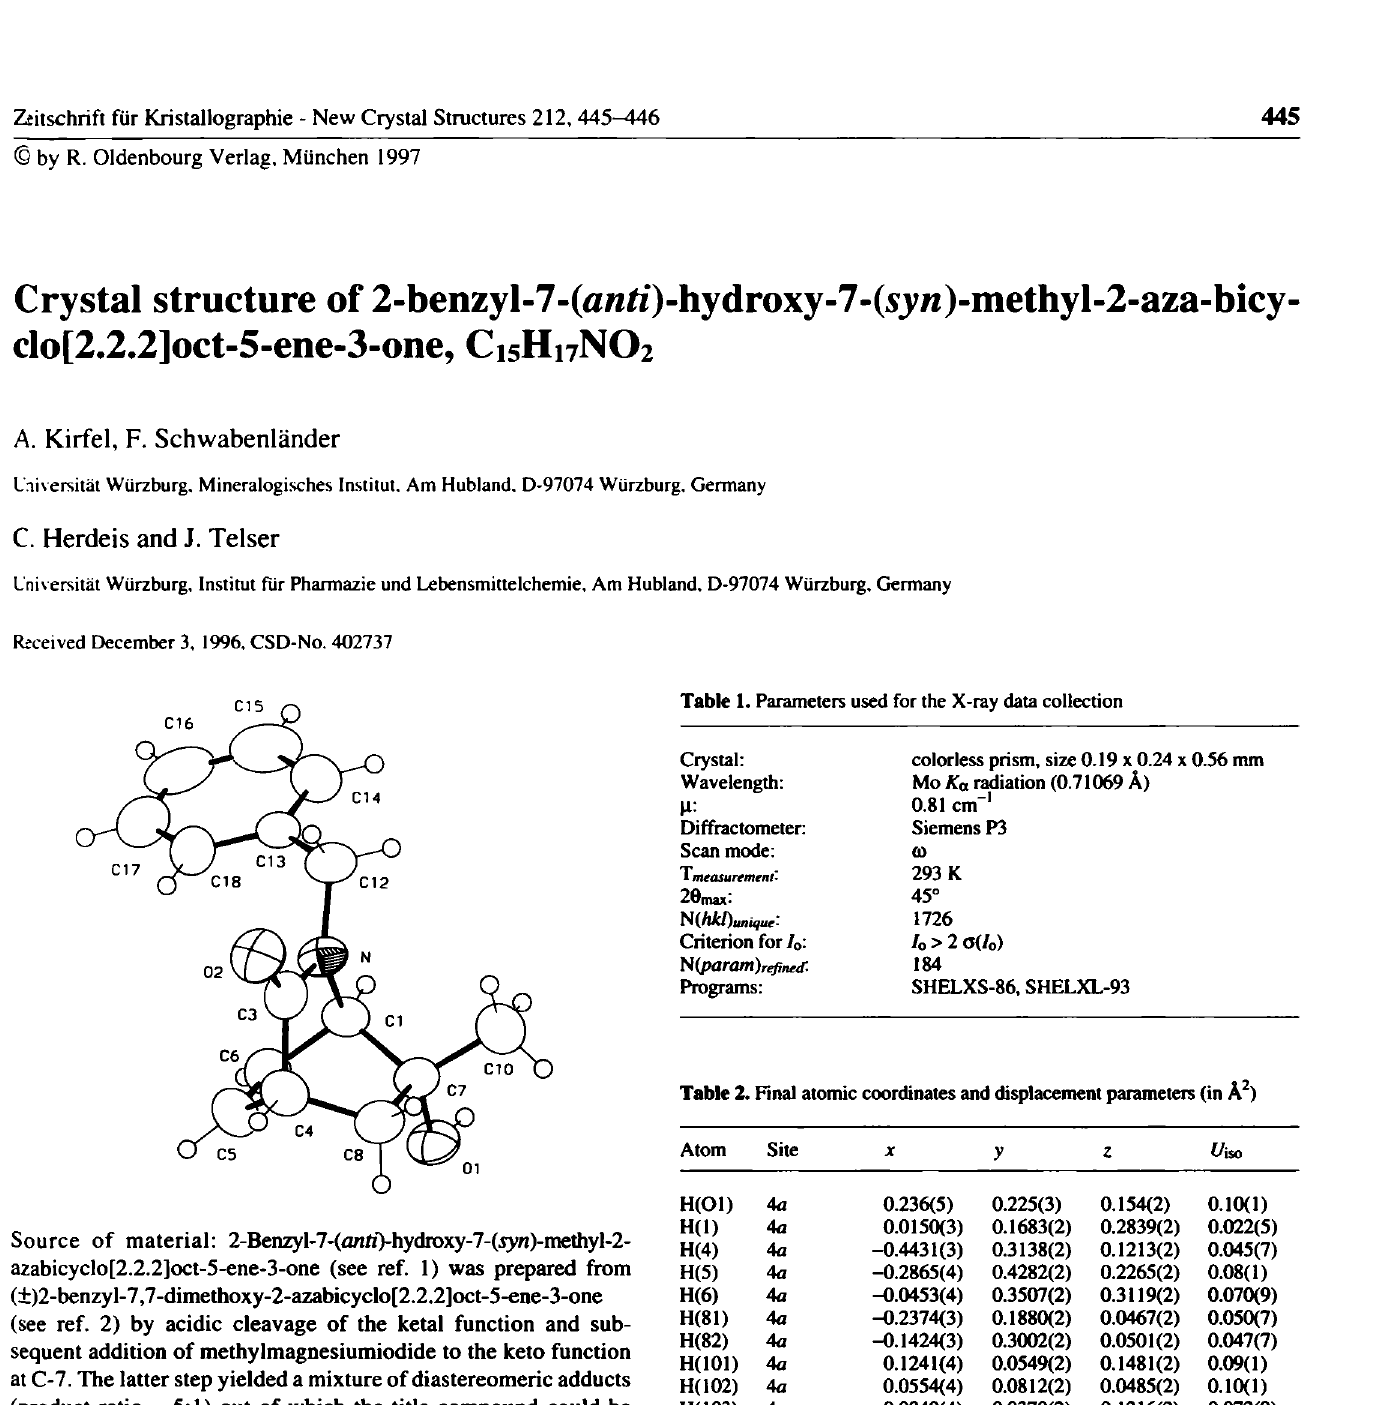
Table 3. Final atomic coordinates and displacement parameters (in Ä 2 )